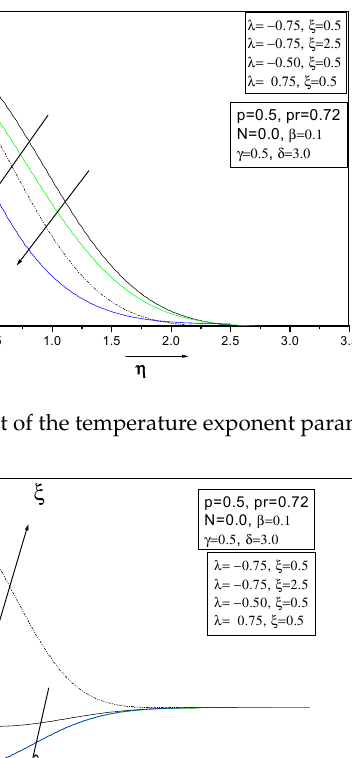
Figure 6. Effect of the temperature exponent parameter on velocity profile.